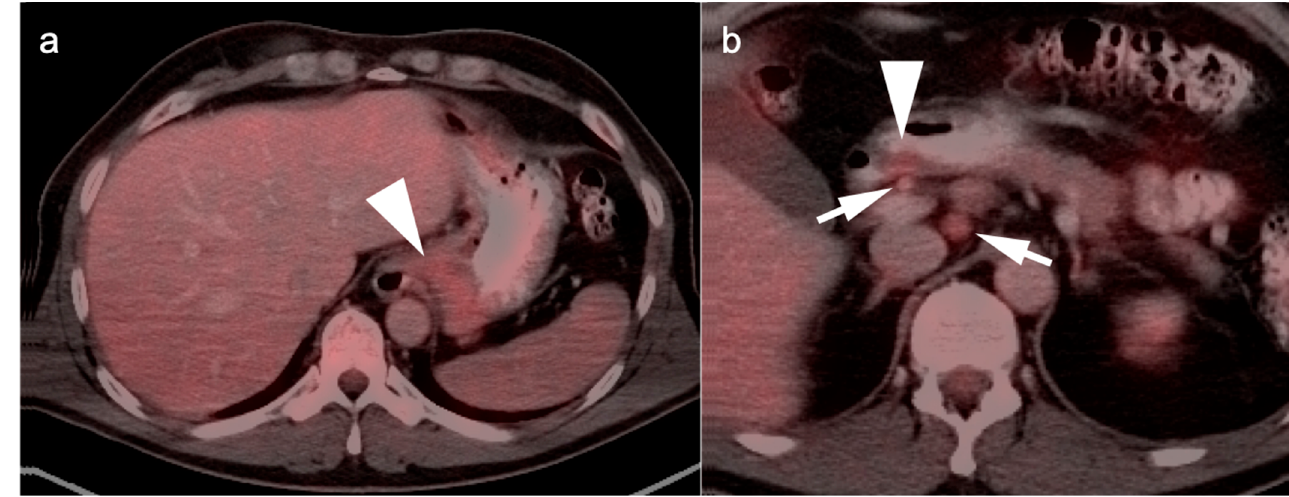
metabolic in gastric carcinoma (white arrow) with widespread hepatic metastases (white arrow-